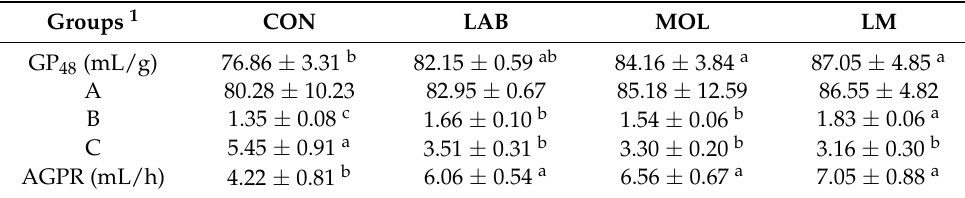
Table 4. Effects of paper mulberry silage treated with different additives on the in vitro gas produc- tion, and kinetic parameters after 48 h of incubation.